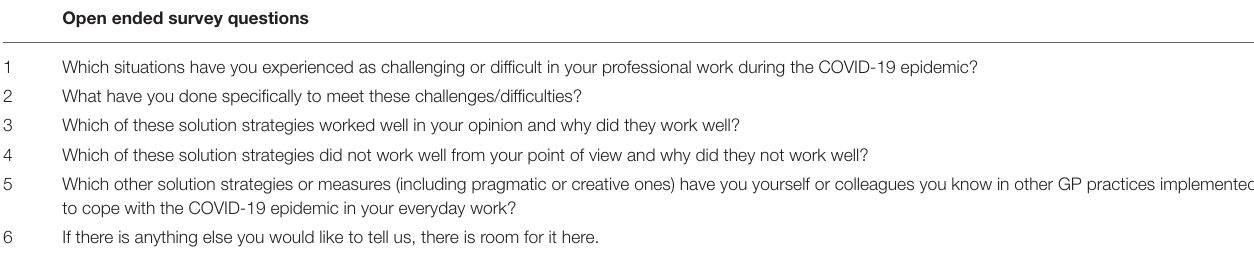
TABLE 1 | Wording of open-ended questions in the online-survey. Open ended survey questions